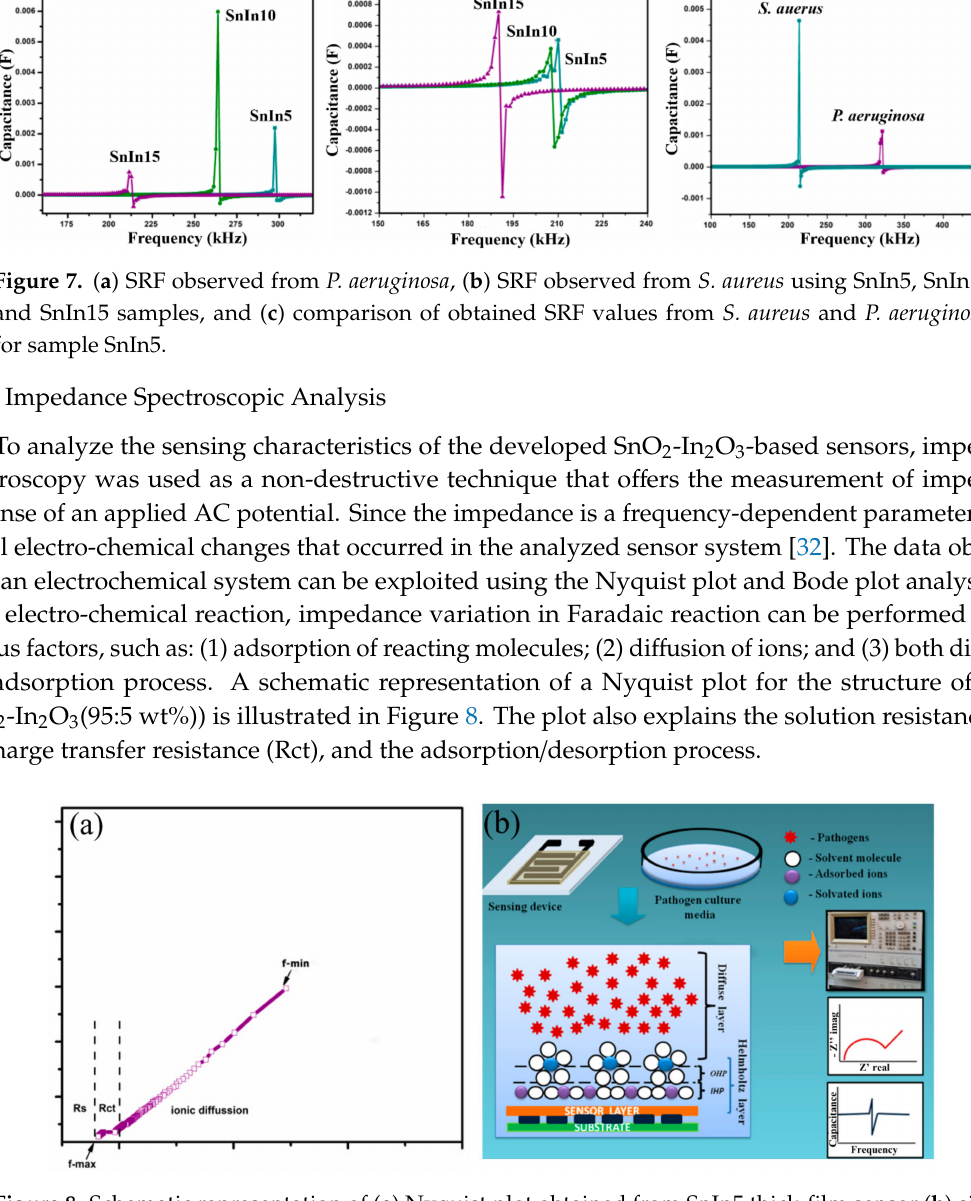
Figure 8. Schematic representation of ( a ) Nyquist plot obtained from SnIn5 thick-film sensor ( b ) site binding model with steps in sensing